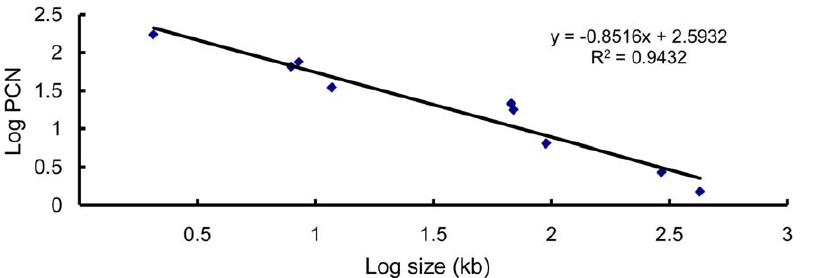
Figure 1. PCN is negatively correlated to molecular mass. The dots from left to right in the graph represent the log values of the size and PCN of pBMB2062, pBMB7921, pBMB8513, pBMB11, pBMB67, pBMB69, pBMB95, pBMB293, and pBMB400, respectively. The PCN and size of each of the nine plasmids in strain YBT-1520 are shown in Table 1. doi:10.1371/journal.pone.0016025.g001 PLoS ONE |